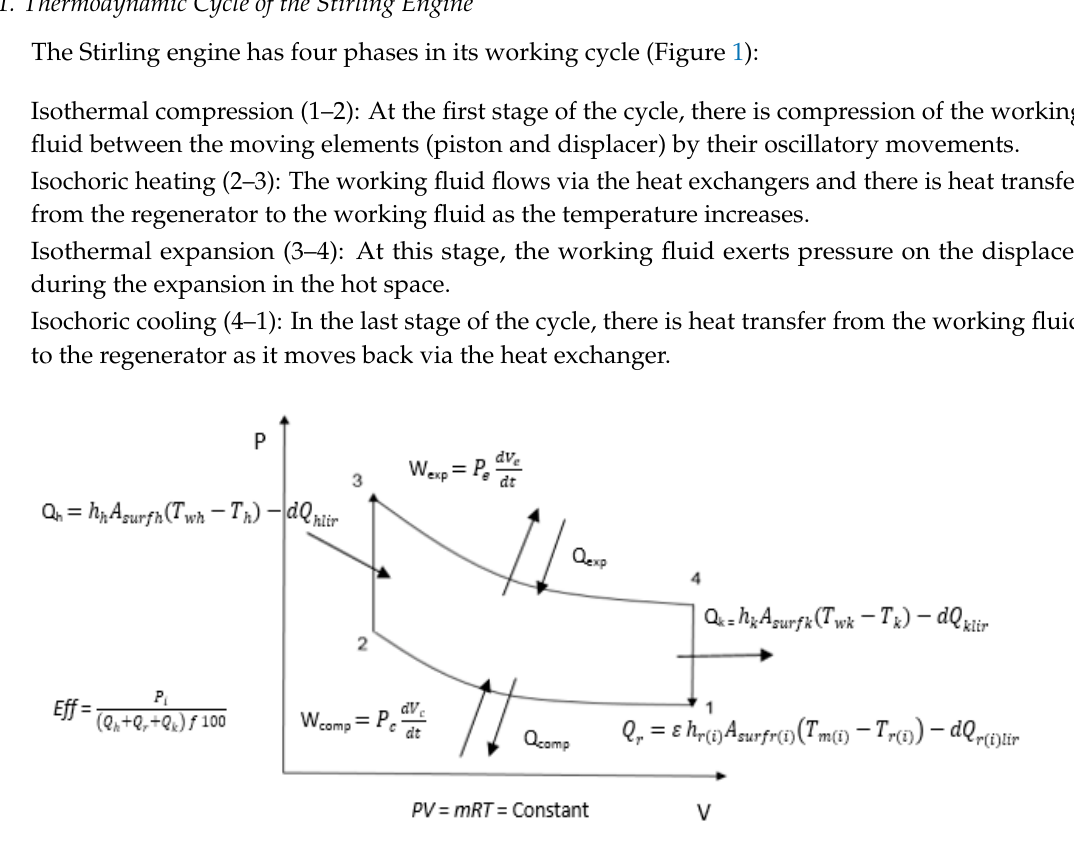
Figure 1. Pressure to volume diagram of the ideal Stirling cycle indicating the influence of the heat exchangers. heat